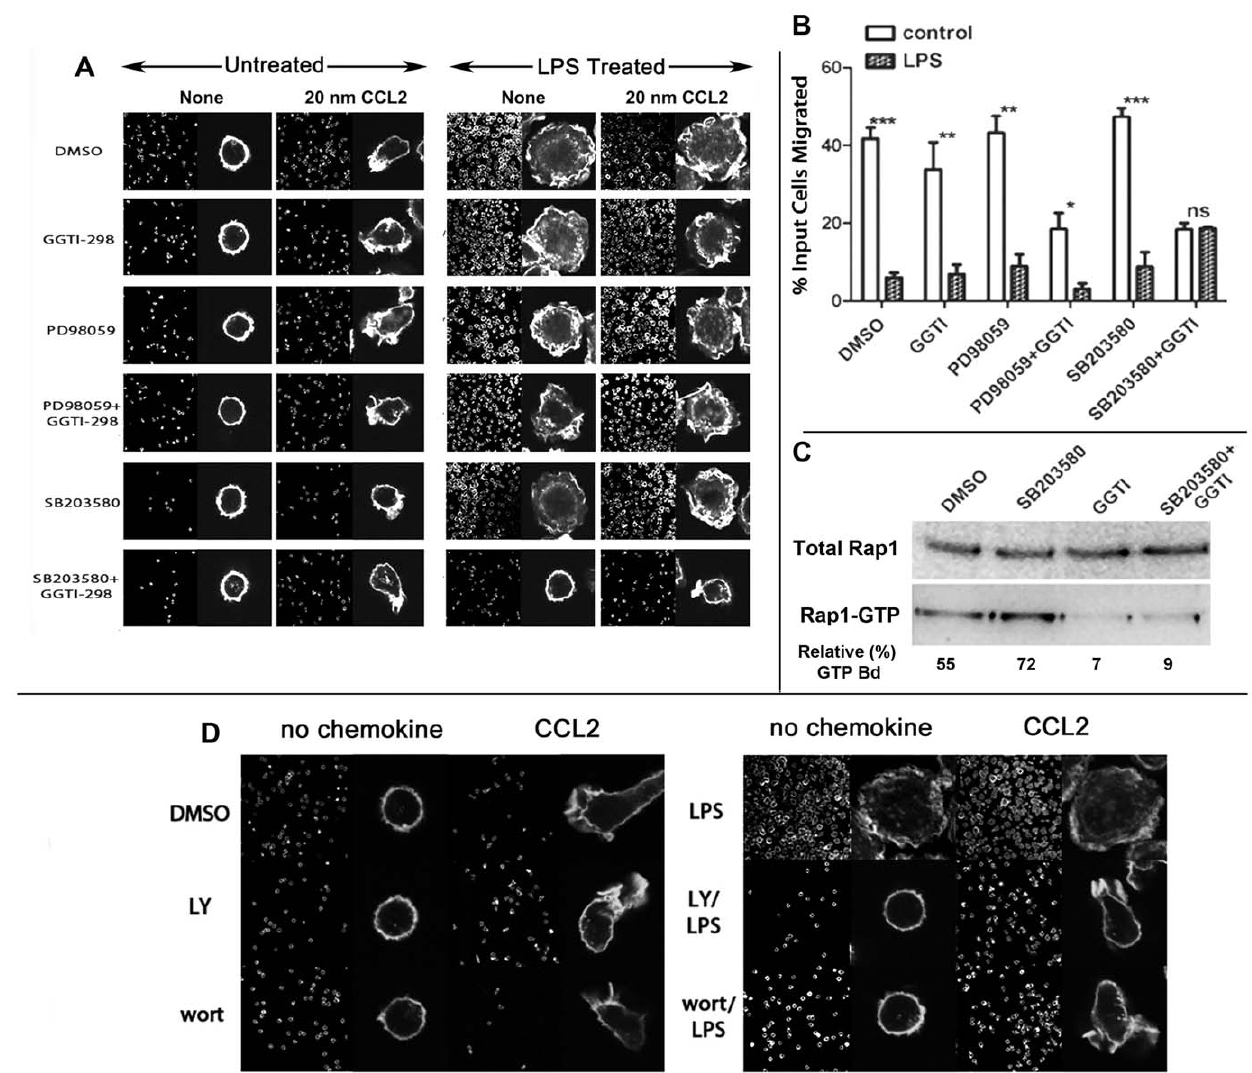
Figure 7. Simultaneous inhibition of Rap1 and p38 MAPK or PI3K inhibition reversed LPS induced block of F-actin polarization and chemotaxis in moncoytes. A ) Monocytes in RPMI with 5% FBS were treated with 20 m M Rap1 inhibitor GGTI-298 (Calbiochem, EMD Biosci Corp), 10 m M 42/44ERK MAPK inhibitor PD98059 (Cell signaling), 10 m M p38 MAPK inhibitor SB203580 (Tocris Corp), 20 m M GGTI-298 + 10 m M PD98059 and 20 m M GGTI-298 + 10 m M SB203580, or DMSO control for 30 min at 37 u C. Cells were plated on cover slips and treated with or without LPS (2 ng/ml) at 37 u C for 15 min, followed by stimulation with 20 nM CCL2 for 2 min. Cells were fixed and stained with phalloidin-488, and images were collected with Leica TCS SP5. B ) 10 7 monocytes were treated with inhibitors as described above for 30 min followed by a 15 min incubation with or without (control) LPS (2 ng/ml). , 0.5 6 10 6 LPS treated or untreated cells in 100 m l of RPMI with 1% FBS were loaded in the upper Transwell chambers (Nunc 5.0 m m) challenged with or without 20 nM CCL2 in the bottom chambers, and incubated at 37 u C CO 2 incubator for 2 h. Chemotaxis was measured as described under Methods. Migrated cells for control and LPS treatments after respective inhibitors are plotted pair wise in the histograms (with error bars). n=3, *** p , 0.01, ** p , 0.04, * p , 0.05. C ) LPS induced Rap1 activation was inhibited in monocytes pretreated with GGTI-298 alone or with GGTI- 298 and p38 MAPK inhibitor, SB203580, but not with SB203580 alone. Activated (GTP + ) Rap1 was extracted from cytoplasmic extracts using a commercial pull-down kit followed by SDS/PAGE and imunoblotting with anti-Rap1 mAb. Numbers represent relative fraction (%) of Rapi that was activated (n=3). D ) PI3K inhibitors reversed LPS induced block of F-actin polarization in monocytes stimulated with CCL2. Monocytes in 5%FBS/RPMI were treated with 50 m M LY2940002, 1 m M wortmannin, or DMSO control for 30 min 37 u C. Cells were plated on cover slips and treated with or without LPS (2 ng/ml) at 37 u C for 20 min, followed by 20 nM CCL2 for 2 min. Cells were fixed and stained with phalloidin-488, and images were collected with Leica TCS